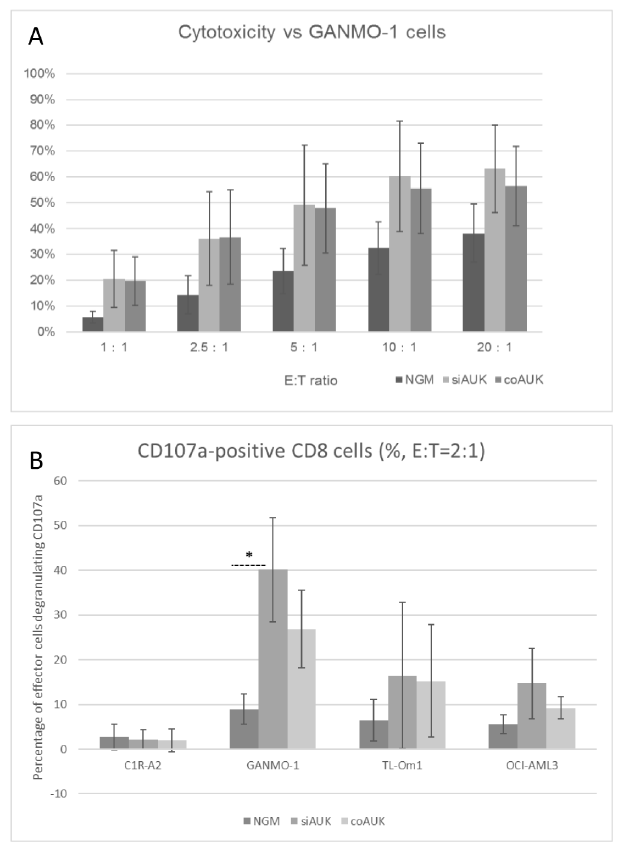
Fig 3. Cytotoxic response against AURKA-positive GANMO-1 cells. (A) Total cell killing of Chromium- labelled GANMO-1 cells was assessed by Chromium release after 3 hours co-culture with NGM, coAUK, or siAUK effector cells. (B) Effector cells were co-cultured (E:T = 2:1) for 3 hours with a range of HLA A * 0201 + target cells in the presence of CD107a antibody (C1R-A2 is an AURKA-negative control). CD107a degranulation was assessed by flow cytometry ( * p < 0.05, One-way ANOVA with Tukey ’ s test, n = 3, ± S.D.).